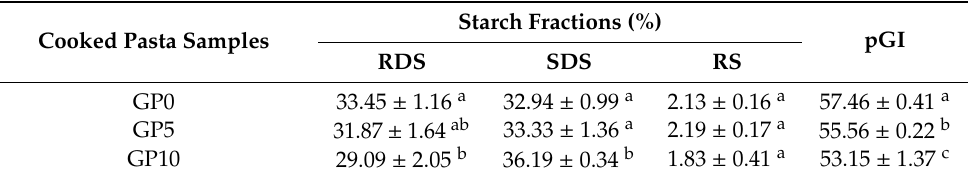
Table 4. Starch fractions expressed as percentages of the total starch and predicted glycemic index (pGI) of cooked control pasta (GP0) and cooked pasta fortified with di ff erent percentages of grape pomace (GP5 and GP10). RDS: rapidly digested starch; SDS: slowly digested starch; RS: resistant starch. The values are reported as mean ± standard